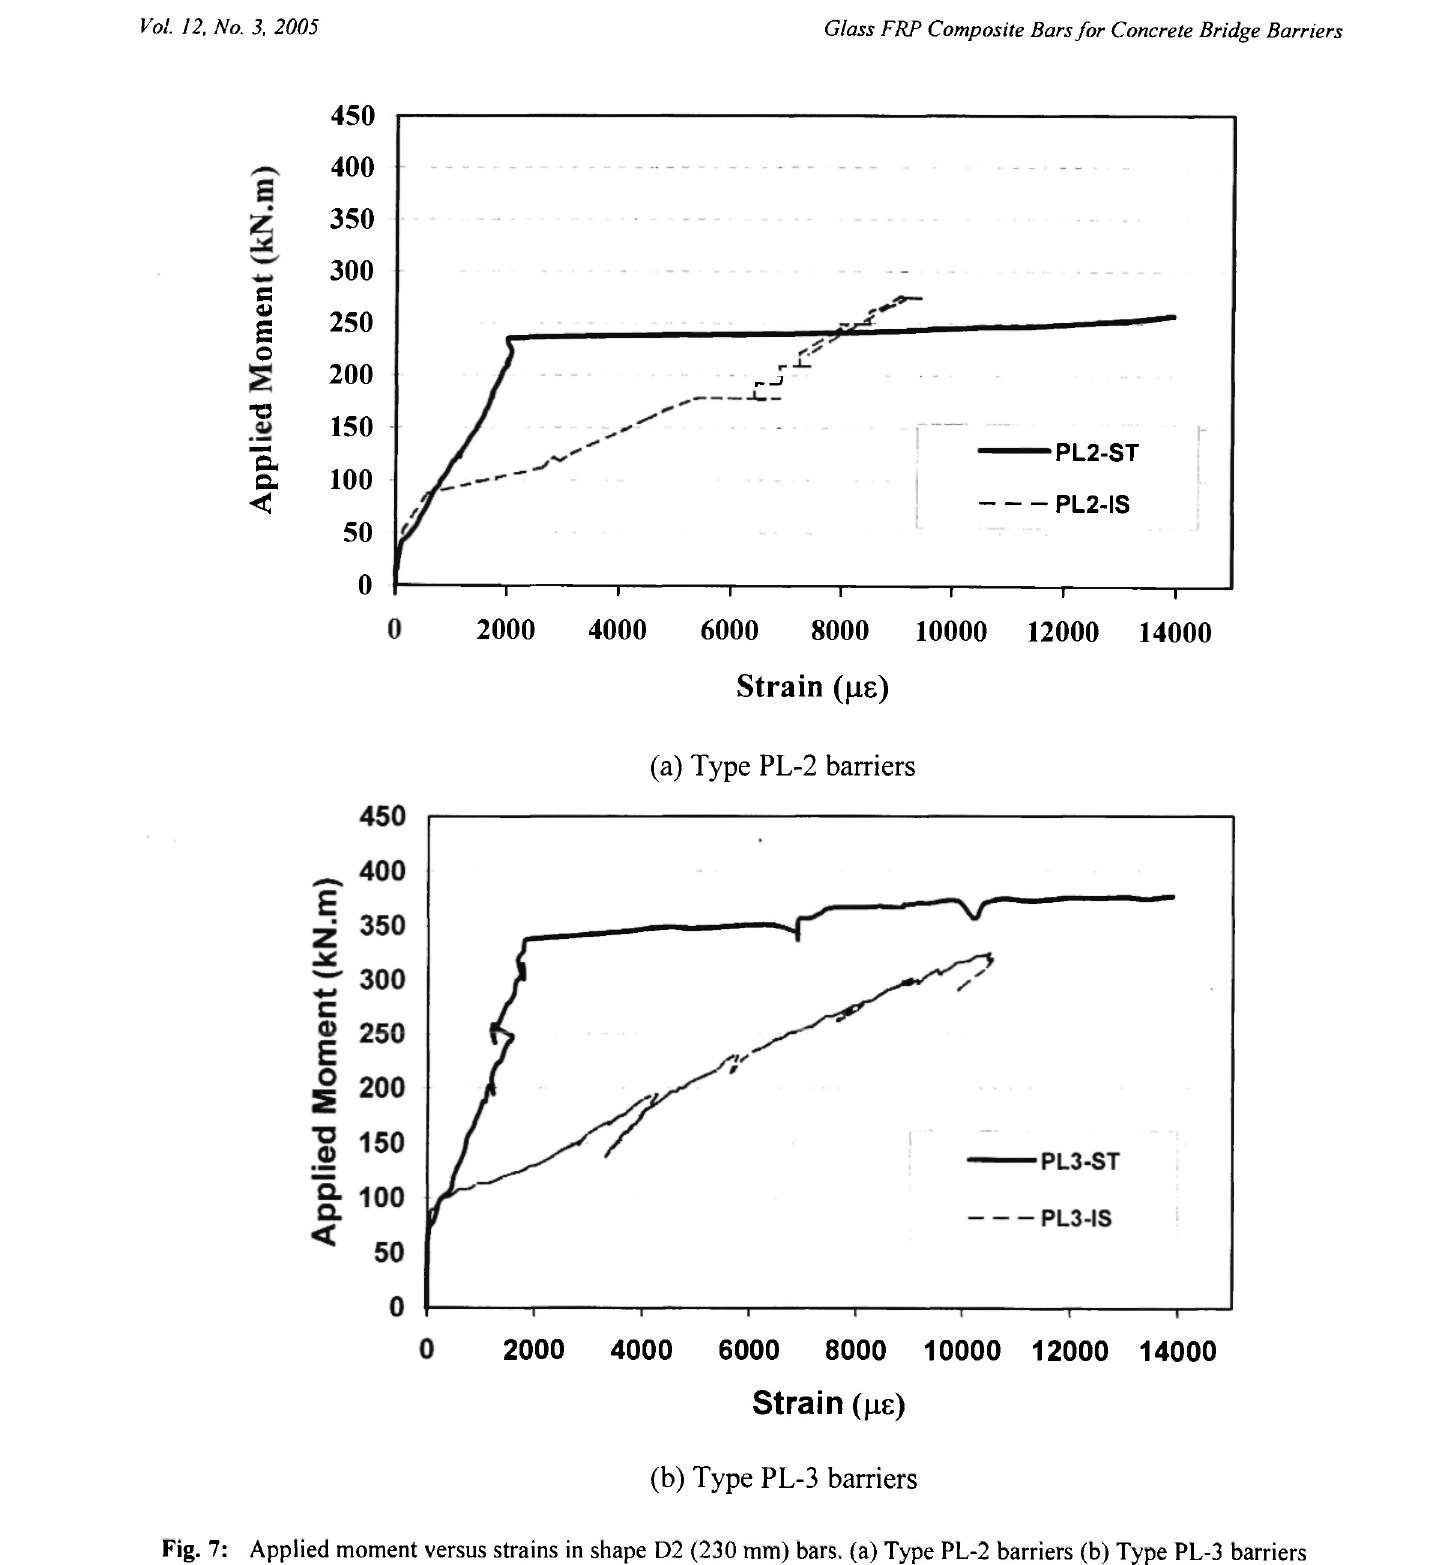
Fig. 7: Applied moment versus strains in shape D2 (230 mm) bars, (a) Type PL-2 barriers (b) Type PL-3